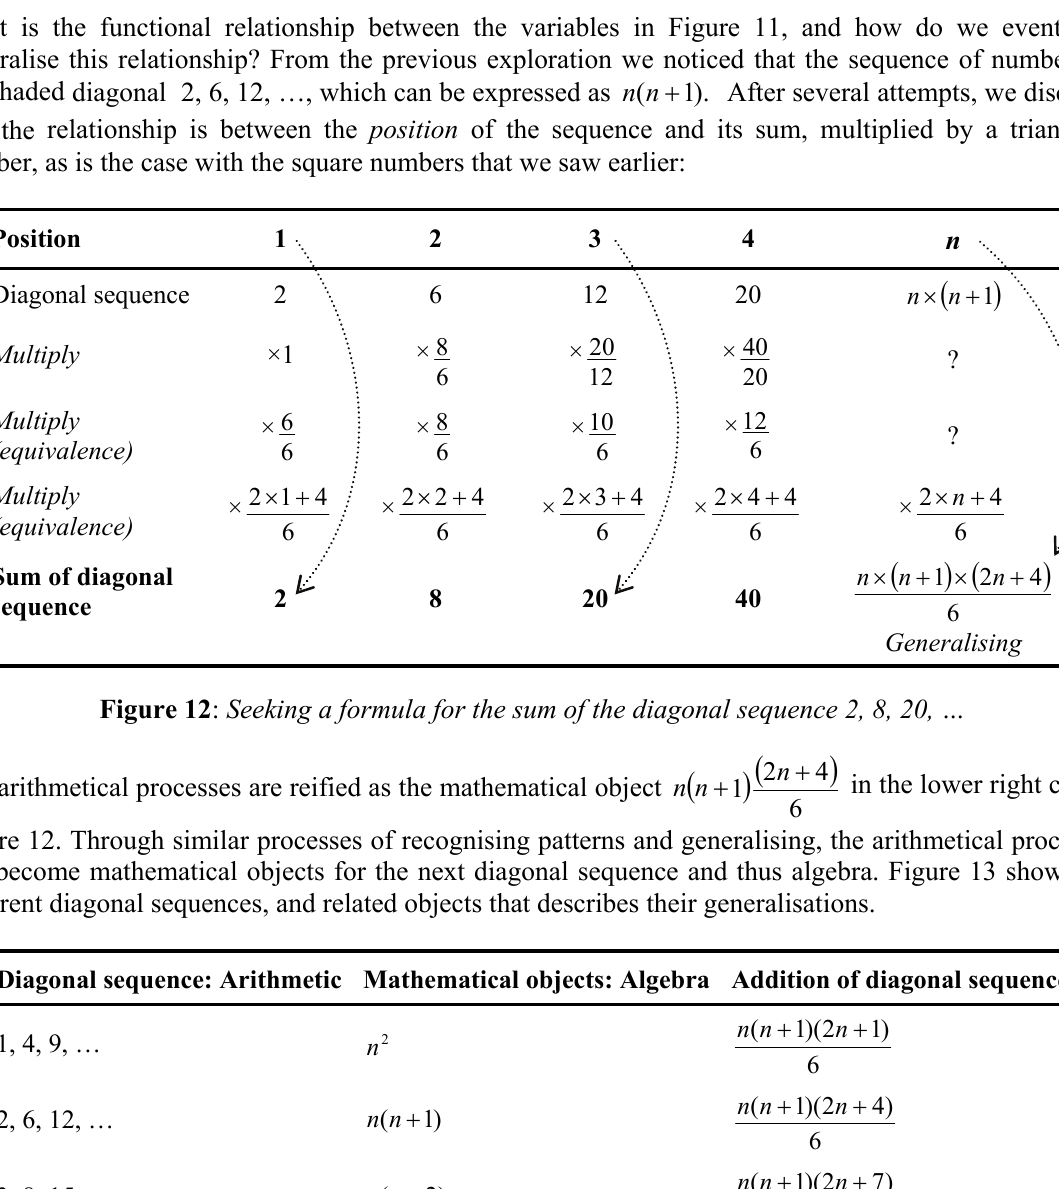
Figure 11 : Seeking a formula for the sum of diagonal sequences in Figure 9